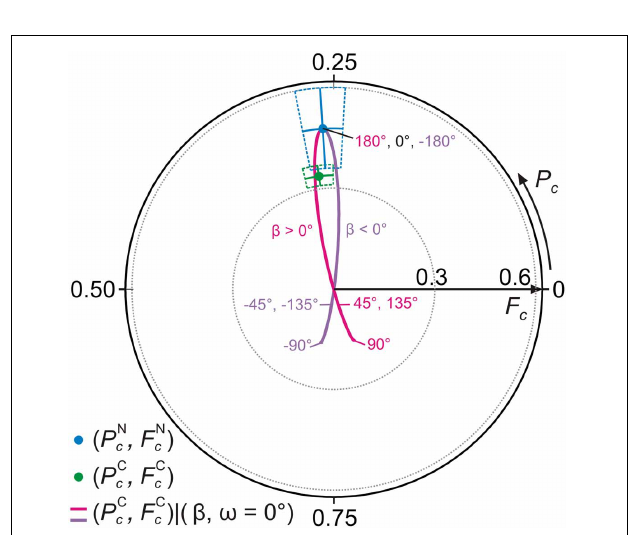
FIGURE 9 | Results of NIXSW simulations for AB, tuning the torsion angle β . Argand diagram of the NIXSW experimental results (green and blue dots, Figure 6 ) and NIXSW simulations of carbon structure parameters ( P C c , F C c ) for − 180 ◦ ≤ β ≤ 0 ◦ (violet line) and 0 ◦ ≤ β ≤ 180 ◦ (magenta line) with β = 0 ◦ and d N − Ag = 2 . 97Å.